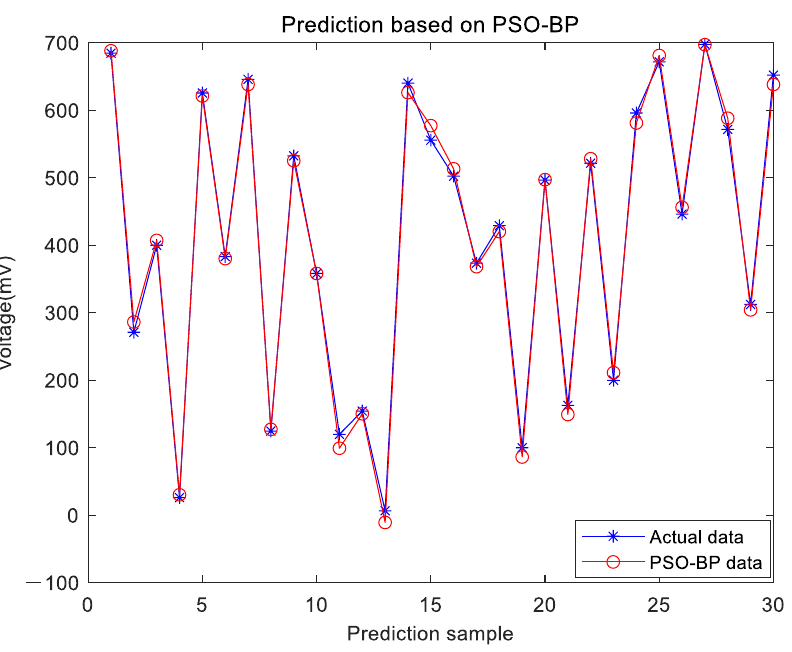
Figure 9. Prediction based on PSO-BP.